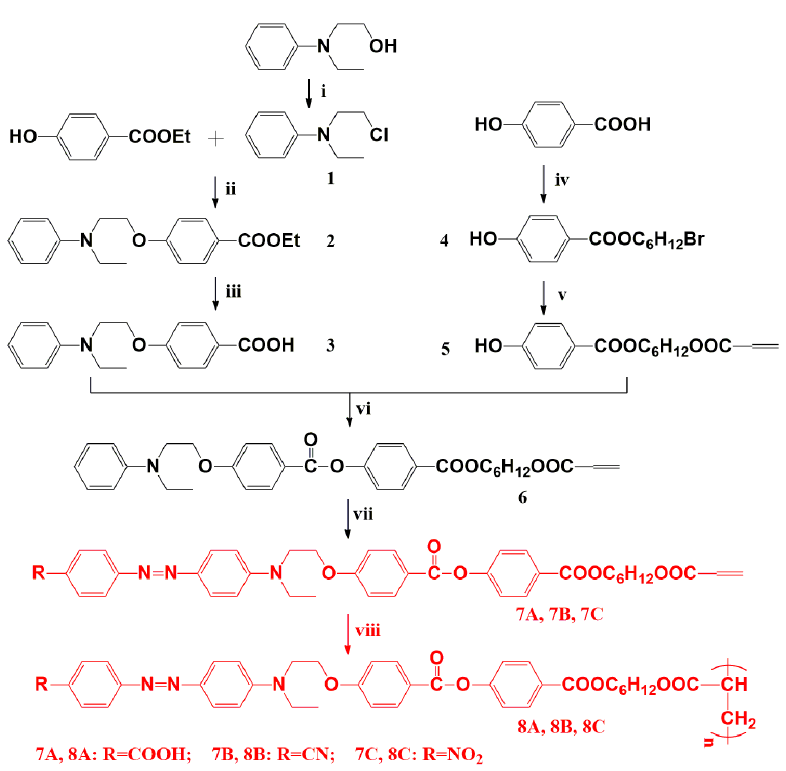
Figure 1. Synthetic route for the polymers 8A , 8B , and 8C .